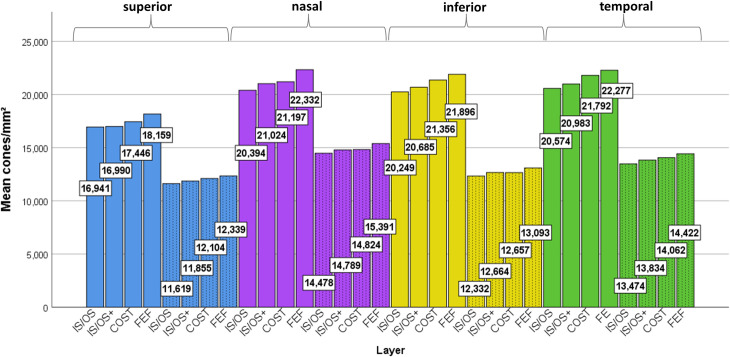
Mean cone density of all 4 planes, 4 meridians (blue = superior, purple = nasal, yellow = inferior, green = temporal) and 2 eccentricities (solid fill = ecc 2.5°, dashed fill = ecc 6.5°).N = 20 eyes. Density is generally higher at a foveal eccentricity of 2.5° compared to 6.5°. In all 4 meridians and 2 eccentricities, density was highest in the FEF images, followed by COST, IS/OS+ and ISOS. Significant differences are marked in Table 2.